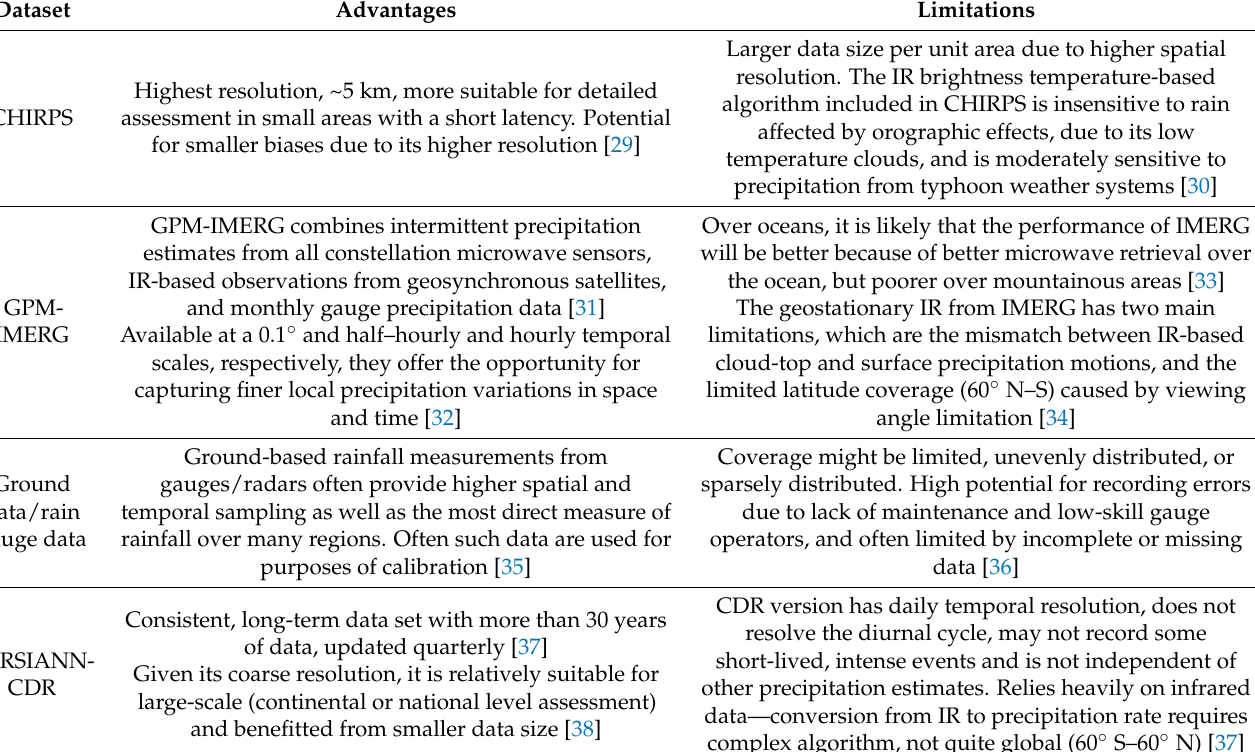
Figure 1. Study area, with the background of elevation, gauges (black triangles) distribution and pixels corresponding to CHIRPS (red-box), GPM (black box), and PERSIANN (blue-box) boundaries. Green lines are river networks. Name of gauges: JU = Juanda, KK = Karangkates, KP = Karangploso, NG = Nganjuk, PS = Pasuruan, TP = Tanjung Perak. Table 1. Advantages and limitations of each rainfall